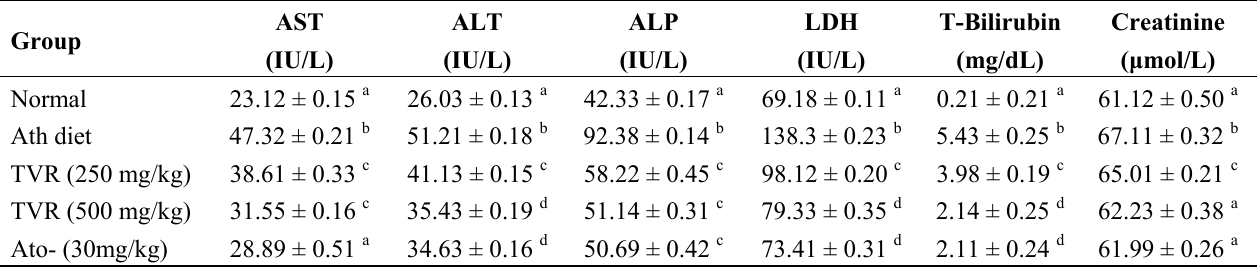
Table 4. Effect of methanolic extract of TVR on serum markers of liver and kidney damage in diet-induced atherogenic